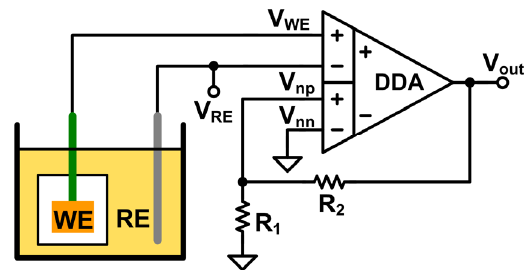
Figure 2. Set-up of the DDA circuit for open-circuit potential